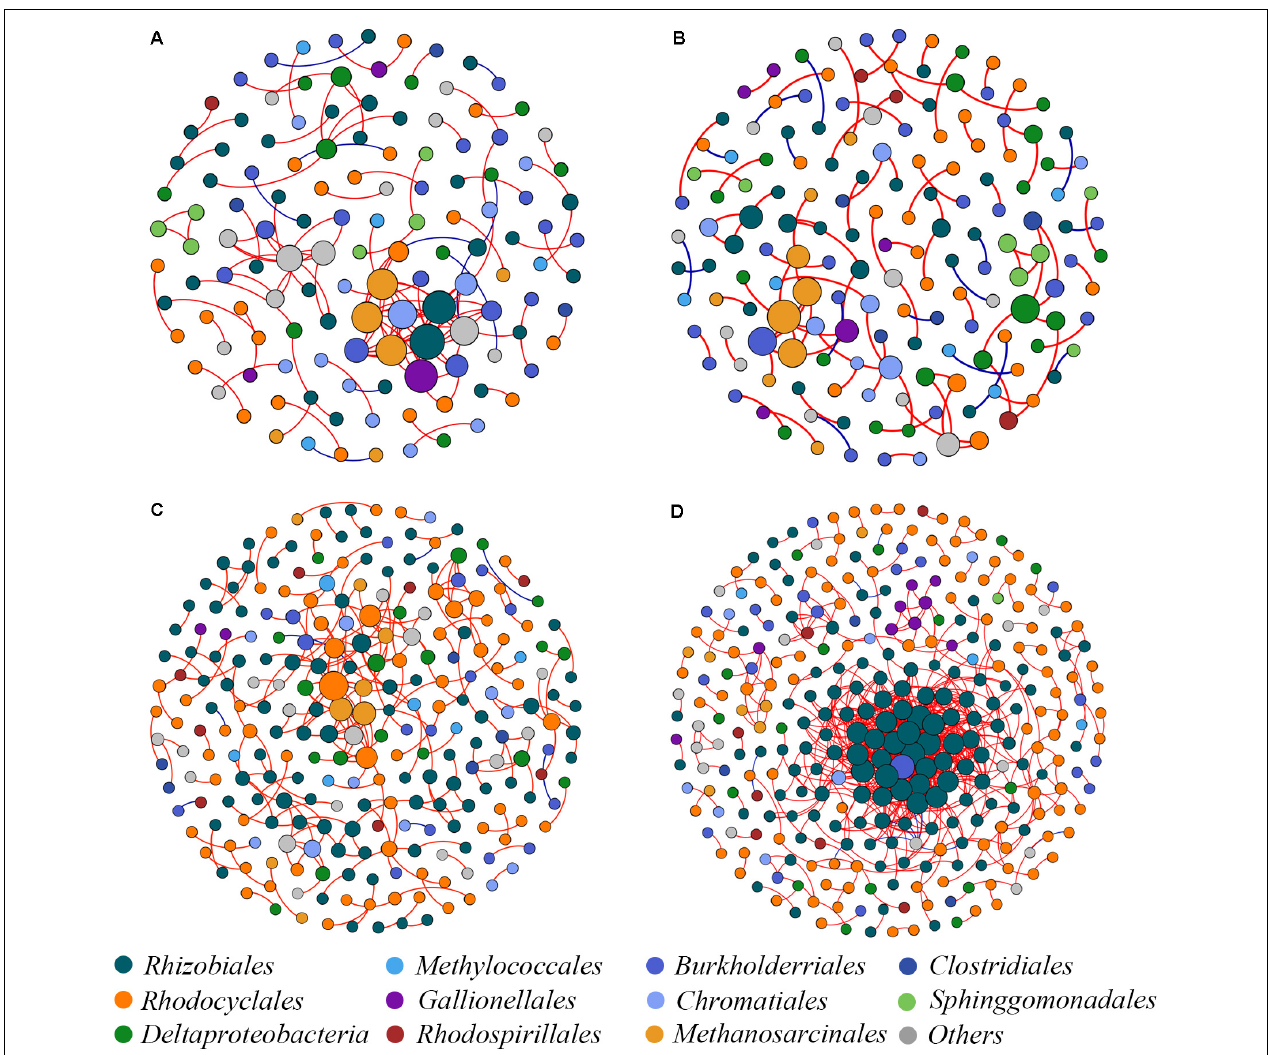
FIGURE 4 | Network co-occurrence analysis of diazotrophic communities basing on nifH gene. (A) aCO 2 & weak-responsive cultivar; (B) eCO 2 & weak-responsive cultivar; (C) aCO 2 & strong-responsive cultivar; (D) eCO 2 & strong-responsive cultivar. Each dot represents a nifH -OTU (node). The size of each node is proportional to number of connections. Each node is labeled at order